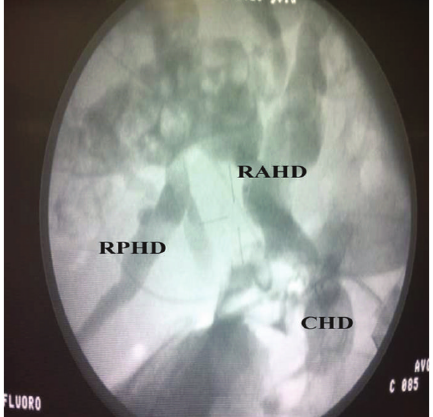
Figure 2: Intraoperative cholangiogram showing the dilated com- mon hepatic duct (CHD), right posterior hepatic duct (RPHD), and the right anterior hepatic duct (RAHD).